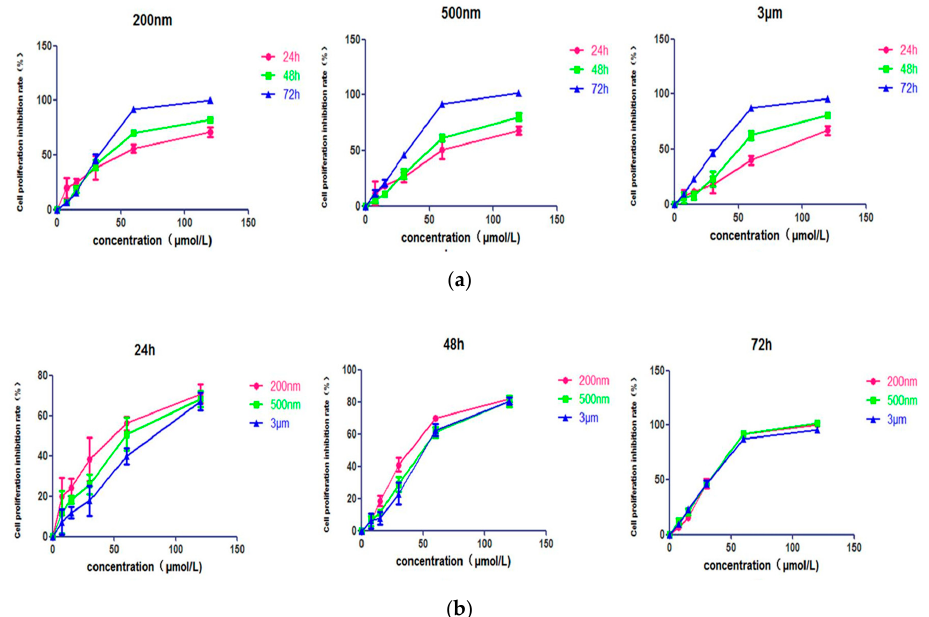
Figure 2. Characterization of cell